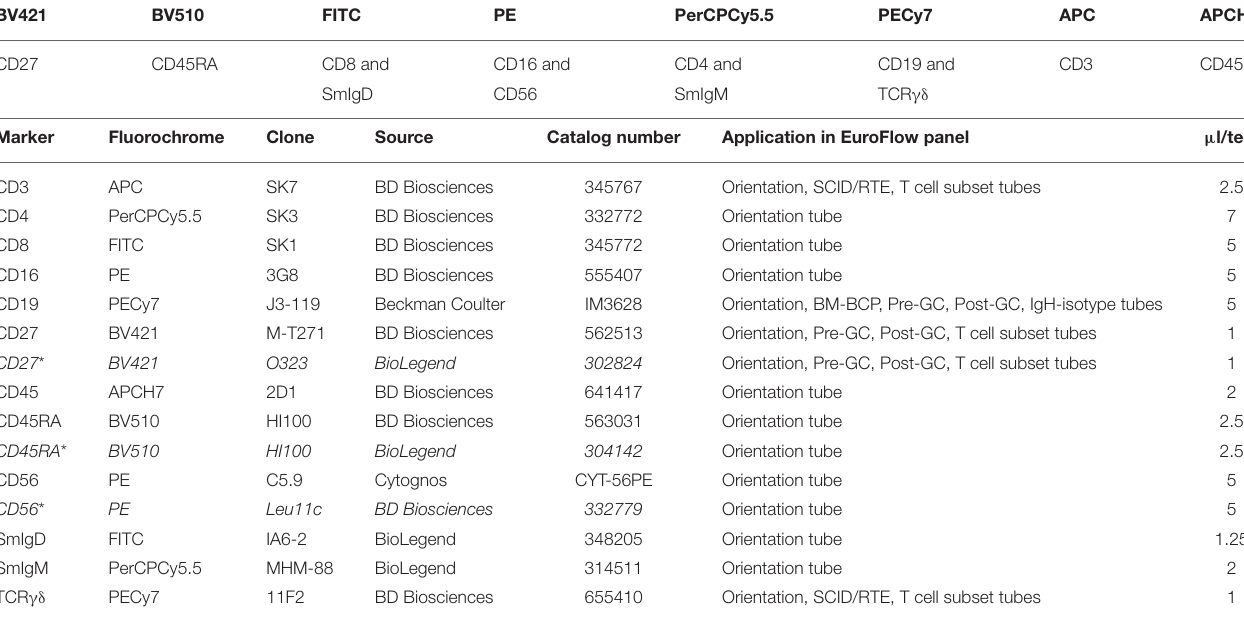
TABLE 1 | Composition of the 8-color PID Orientation tube and technical information on